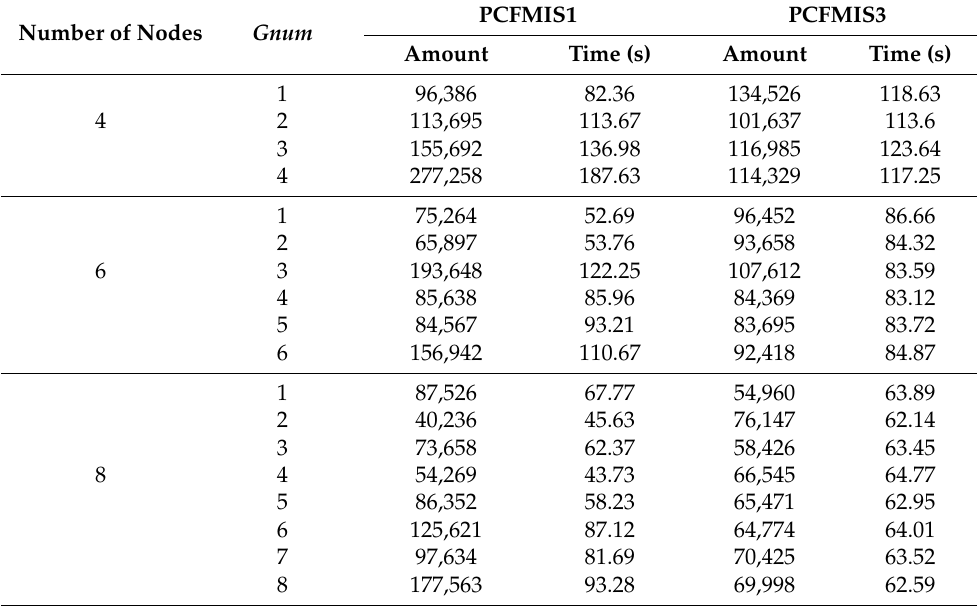
Table 3. The amount of subtrees and computing time in different Gnum groups of